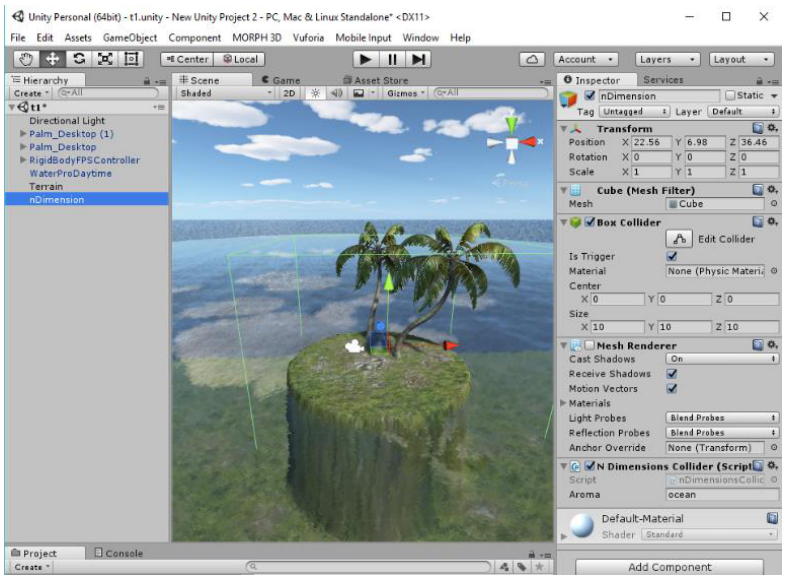
Figure 7. The Unity3D application .